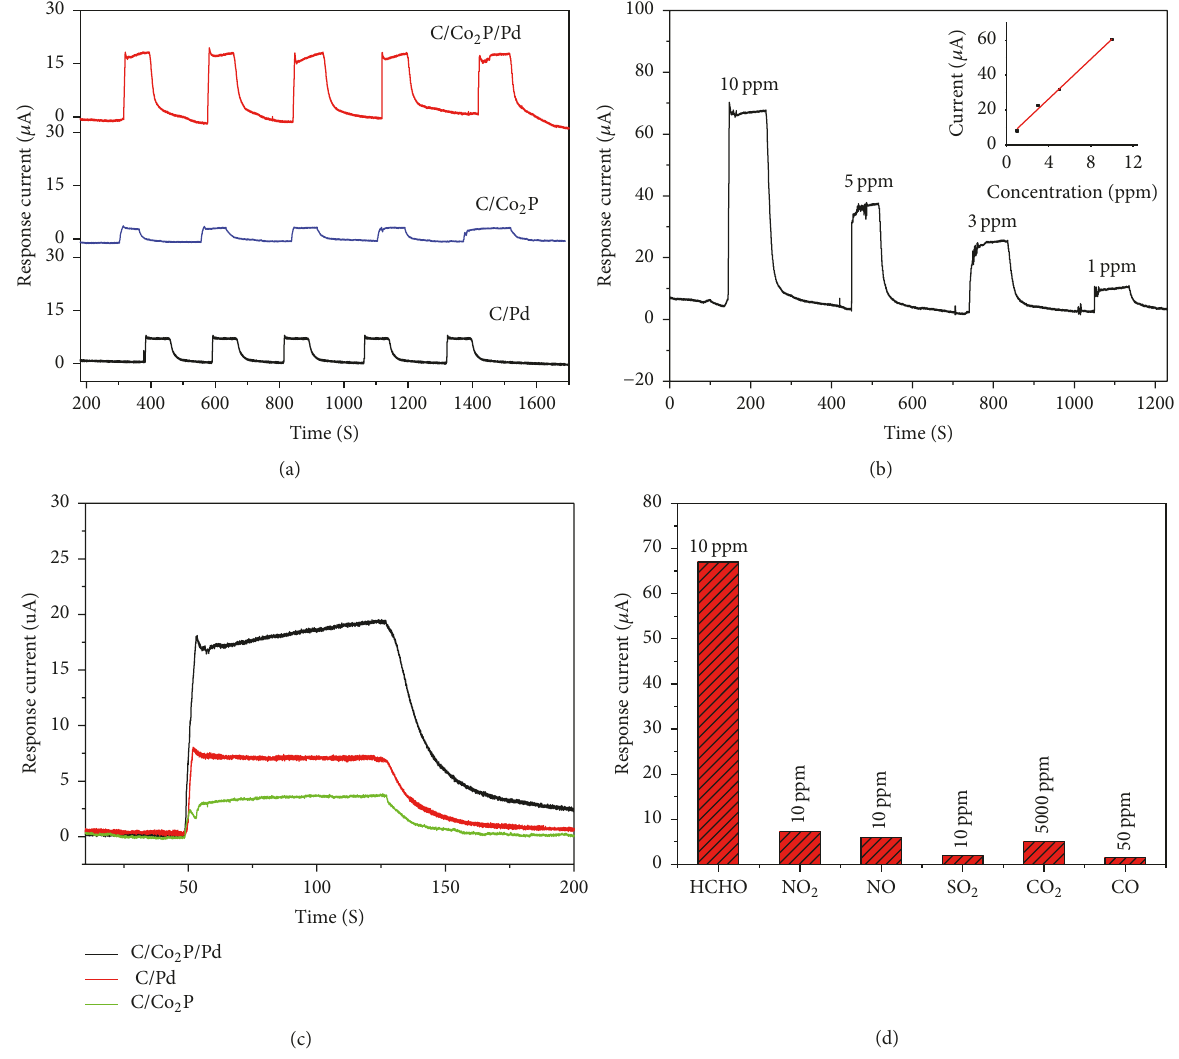
Figure 9: (a) Amperometric current responses of the C/Pd (black line), C/Co 2 P composite (blue line), and C/Co 2 P/Pd (red line) composites based gas sensors to 3 ppm formaldehyde. (b) Typical dynamic current response curves of C/Co 2 P/Pd sensor to formaldehyde ranging from 1ppm to 10ppm (inset: calibration curve). (c) Enlarged part of the current responses to 3 ppm HCHO gas of the C/Pd (red line), C/Co 2 P composite (green line), and C/Co 2 P/Pd (black line) electrode based gas sensors. (d) Bar plot of current response of the C/Co 2 P/Pd composites based formaldehyde sensor to different interfering gases under exposure to 10ppm formaldehyde, 10 ppm NO, 10ppm NO 2 , 10 ppm SO 2 , 5000 ppm CO 2 , and 50ppm CO. Applied potential to working electrode was +0.75 V (versus